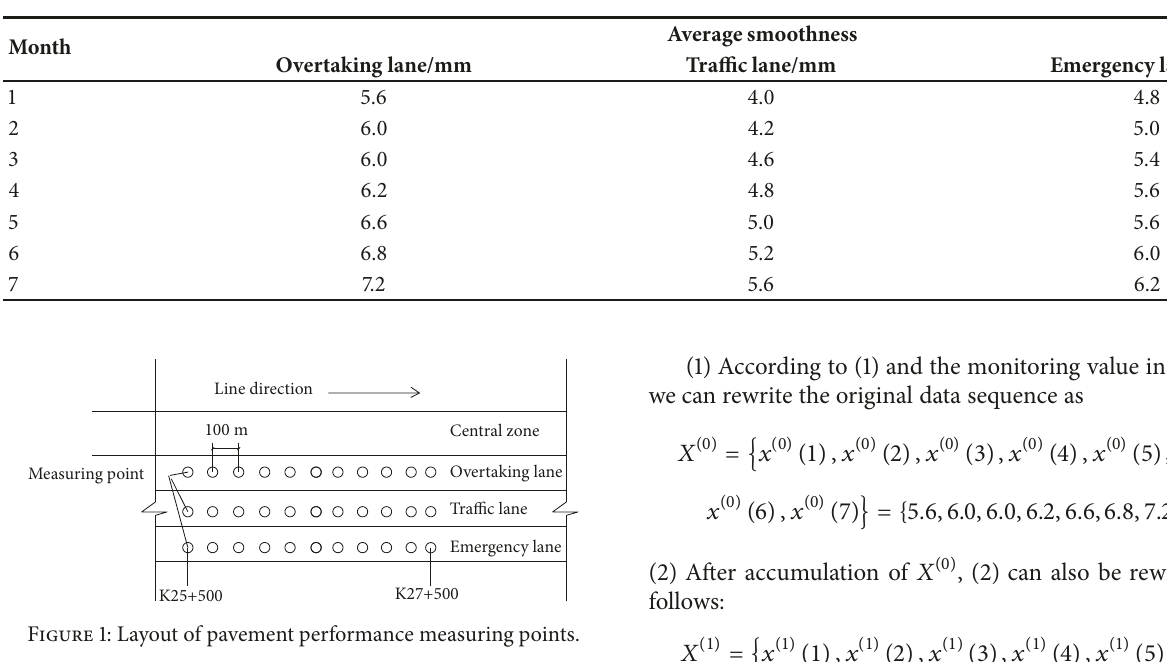
Table 2: The monitoring value of average smoothness for prediction.